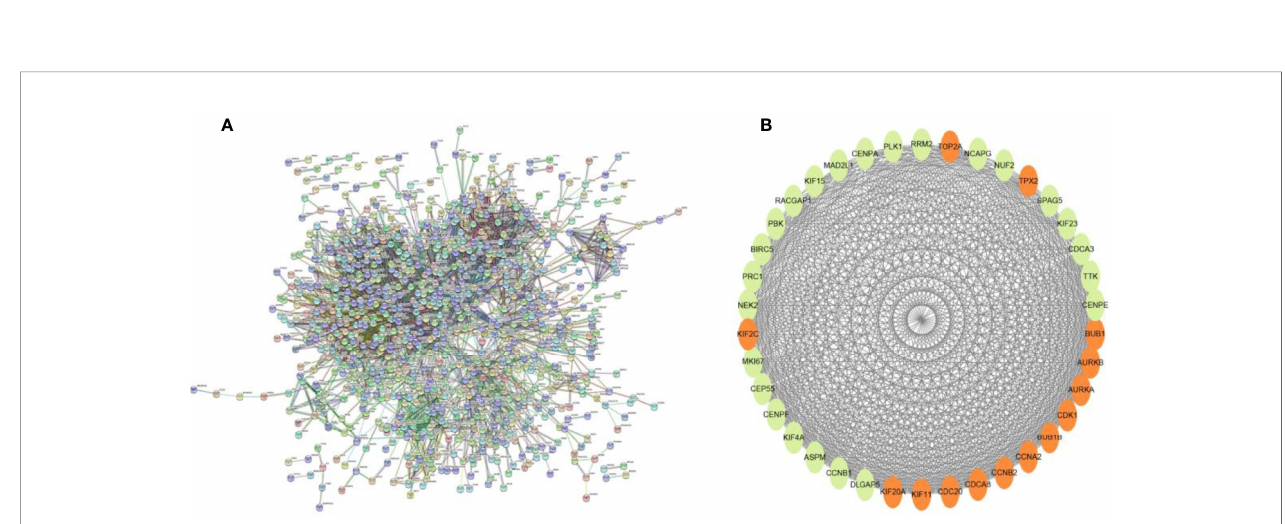
FIGURE 9 | Gene Ontology (GO) and Kyoto Encyclopedia of Genes and Genomes (KEGG) enrichment analysis. (A) GO analysis of the 13-group gene set. (B) KEGG analysis of the 13-group gene set.